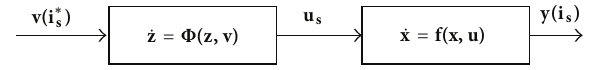
Figure 4: Block diagram of the tandem